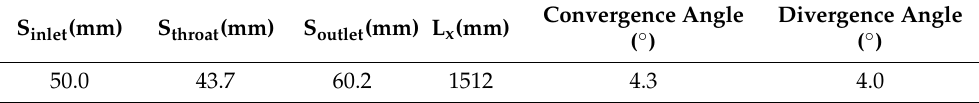
Figure 1. The geometry of the venturi tube. Table 3. Geometric parameters.